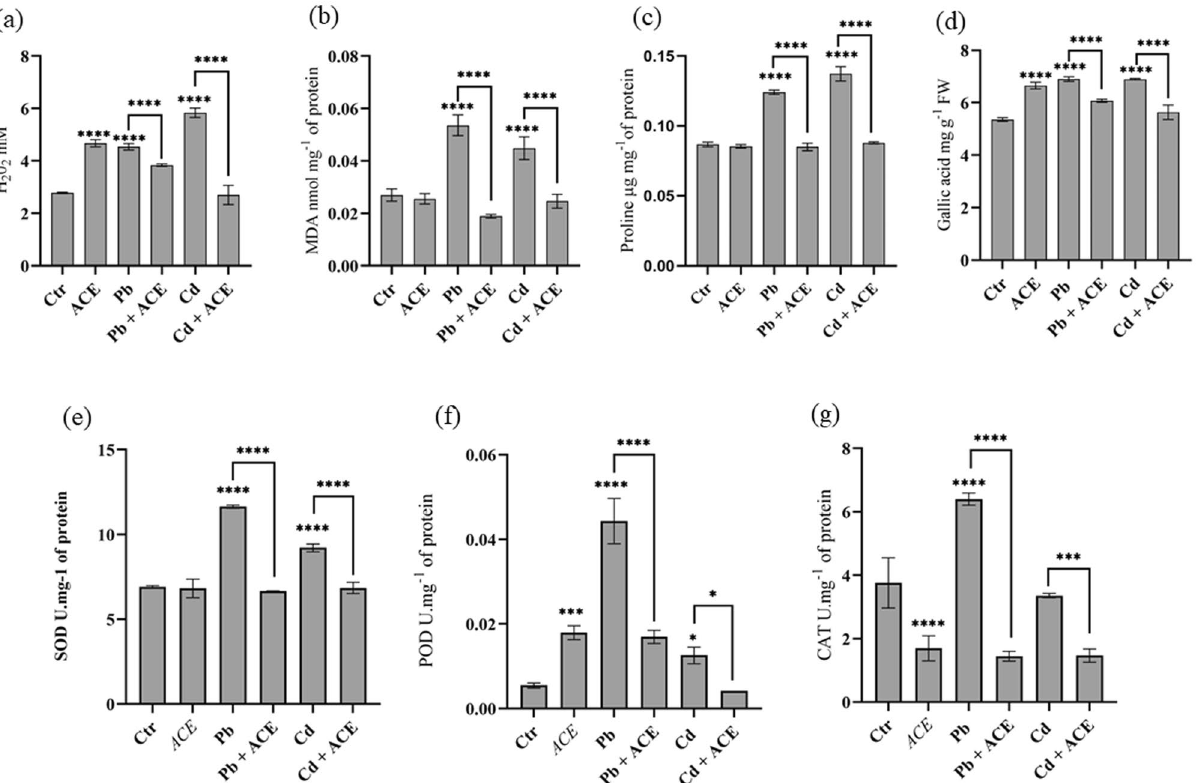
Figure 3. Effect of ACE on antioxidative system of tomato against Pb and Cd stress ( a ) H 2 O 2 , ( b ) MDA, ( c ) Proline, ( d ) Polyphenols, ( e ) SOD, ( f ) POD, ( g ) CAT. [Figure generated by GraphPad prism 9 software, while,